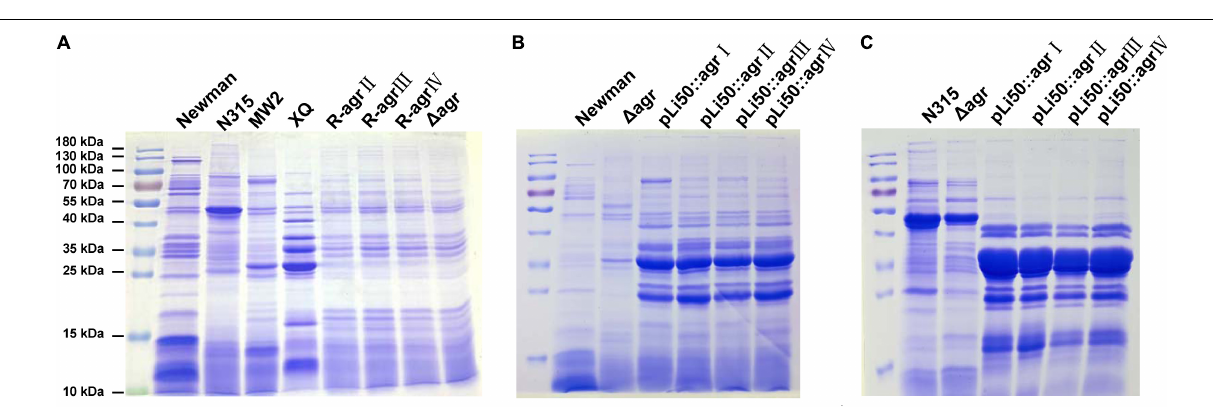
FIGURE 4 | Effects of agr alleles on the transcriptions of staphyloxanthin biosynthesis–related genes. The relative transcription levels of crtN (A–C) and sigB (D–F) were determined. (A,D) The relative transcription levels of wild Newman strain, Newman (cid:49) agrBDC mutant, and agr genomic in situ replacement mutants (R- agr Ito agr IV) of Newman. (B,E) The relative transcription levels of wild Newman strain, Newman (cid:49) agrBDC mutant, and four agr plasmid complemented strains in Newman background. (C,F) The relative transcription levels of wild N315 strain, N315 (cid:49) agrBDCA mutant, and four agr plasmid complemented strains in N315 background.